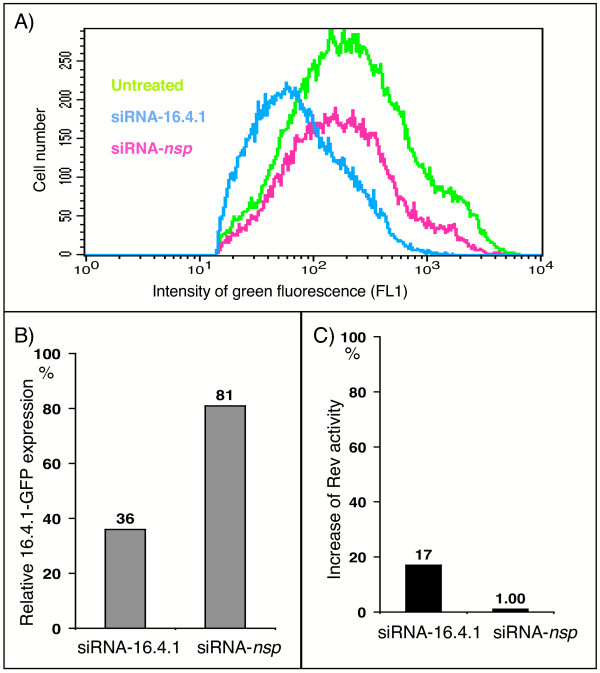
Influences of endogenous 16.4.1 proteins on transactivation capacity of Rev in human cells. (A and B) Downregulation of 16.4.1-GFP expression in HeLa cells by siRNAs. HeLa cells stably expressing 16.4.1-GFP were transfected with a pre-synthesized siRNA directed against a 16.4.1 specific sequence (siRNA-16.4.1) or a non-specific siRNA (siRNA-nsp). Expression of 16.4.1-GFP was quantified by flow cytometry in 40.000 cells. Panel A shows an overlay of GFP-expressing cell populations in untransfected cells (green curve) and after transfection with the 16.4.1-specific siRNA (blue) and the non-specific (red). 16.4.1-GFP expression in untransfected cells was set at 100% and the percentage of down regulation of green fluorescence indicated. siRNA-16.4.1 reduced expression levels of GFP-tagged 16.4.1 to 36% which was similar to the silencing effect of si-GFP which was analyzed as control (not shown). Higher levels of 16.4.1-GFP expression (81%) were observed in cells transfected with the unspecific siRNA-nsp. (C) Enhancement of Rev transactivation capacity by siRNAs targeted against 16.4.1. 293T cells were transfected with siRNA-16.4.1 or siRNA-nsp and Rev activities compared with mock-transfected cells (i.e. cells treated with the RNAi transfection reagent lacking RNA). Transfection of siRNA-16.4.1 increased Rev activity by 17% whereas the unspecific siRNA-nsp increased Rev activity by only 1%.